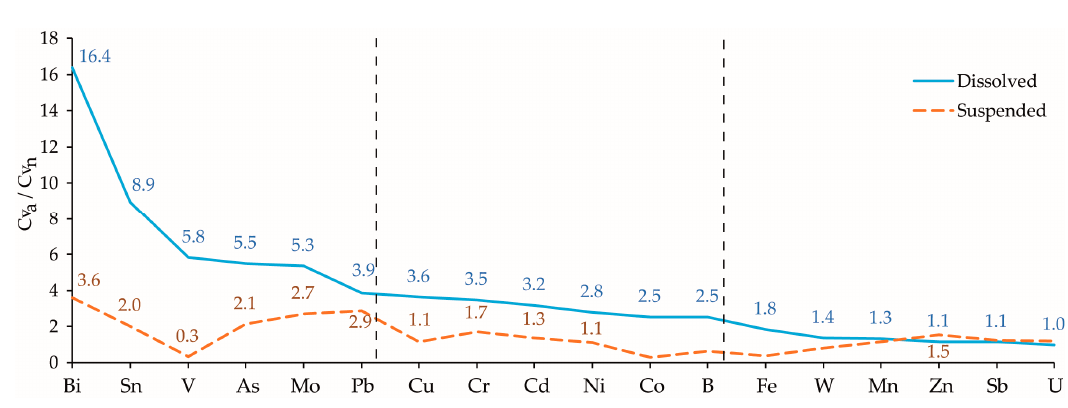
Figure 8. Ratio of the coefficient of variation (Cv) within anthropogenically disturbed (hot spots) areas (Cv a ) and natural (background) areas (Cv n ) for dissolved (blue line) and suspended (orange line) metals in the Selenga River basin.